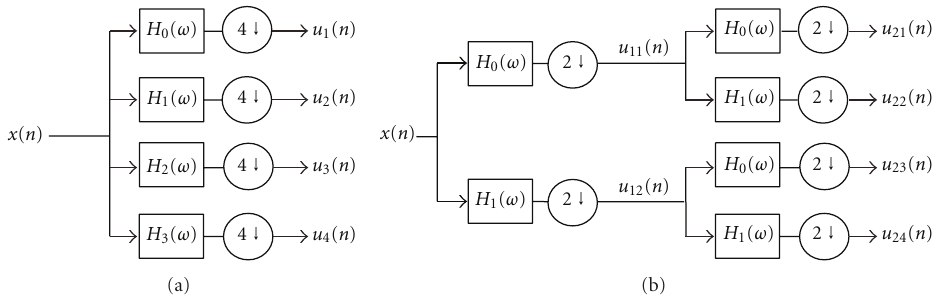
Figure 1: Decomposition structures: (a) 4-channel decomposition, (b) two-stage subband decomposition.